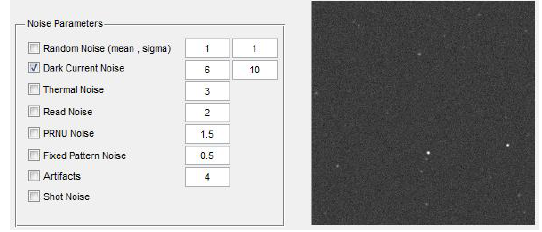
Figure 10. Image noise simulation